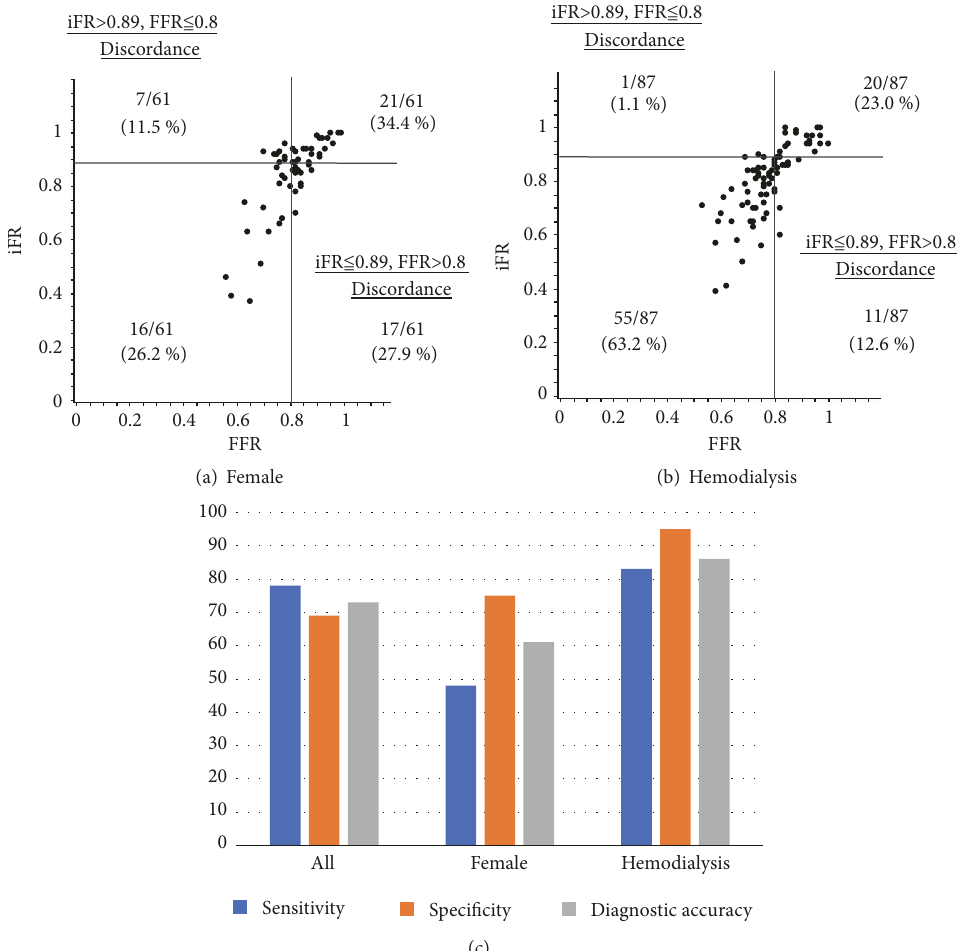
Figure 2: Scatter plots of the iFR and FFR among women (a) and hemodialysis patients (b). Sensitivity, specificity, and diagnostic accuracy of iFR among the entire study population, women, and hemodialysis patients (c). Among women, diagnostic sensitivity was lower than that for the entire population (48% vs 78%, respectively). In contrast, the diagnostic specificity among hemodialysis patients was higher than that for the entire population (95% vs 69%, respectively). iFR: instantaneous wave-free ratio; FFR: fractional flow